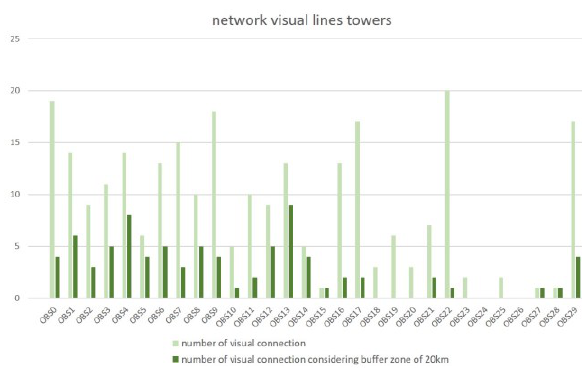
Figure 11. Graph which represents the quantity of visual connections of the towers in both situations - without considering the 20km and considering